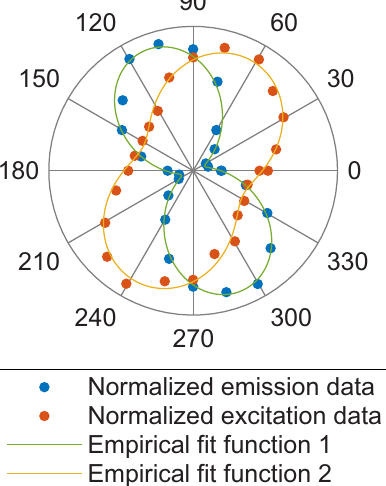
FIG. 8. Quantum emitter C: emission and excitation polariza- tions with green excitation. The normalized emission polariza- tion is shown with blue circles and the normalized excitation polarization is shown with orange circles. The green and yel- low curves are simultaneous fits to the normalized emission and excitation polarizations,